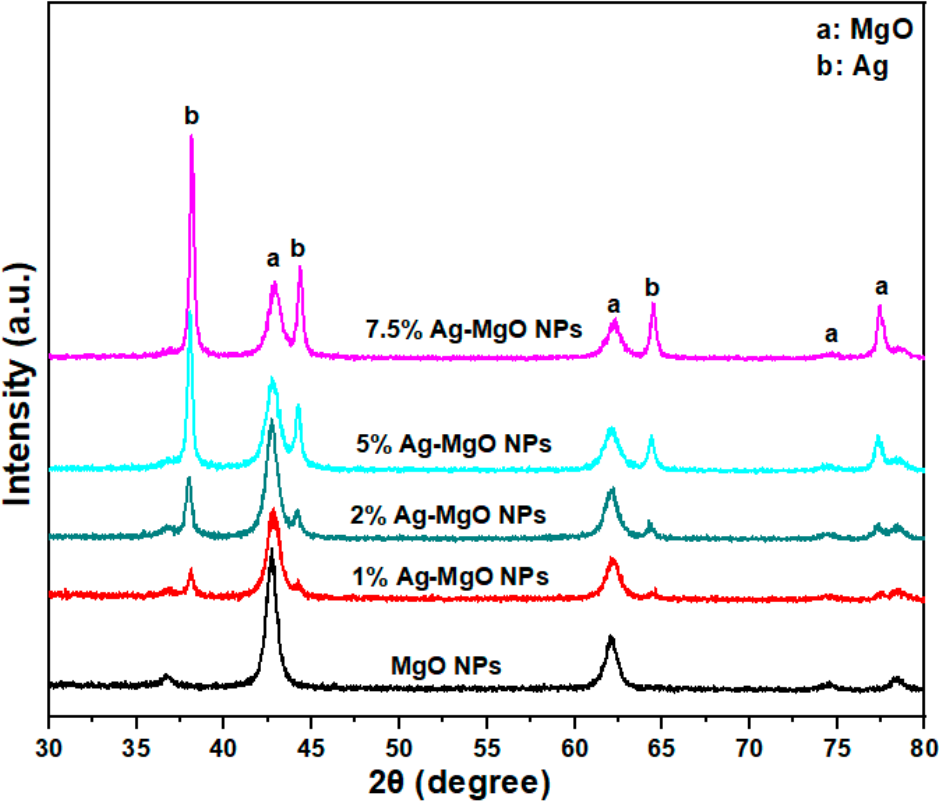
Figure 1. XRD spectra of pure and Ag ‐ doped (1–7.5%) MgO NPs. Table 1. Structure characterization of pure and Ag-MgO